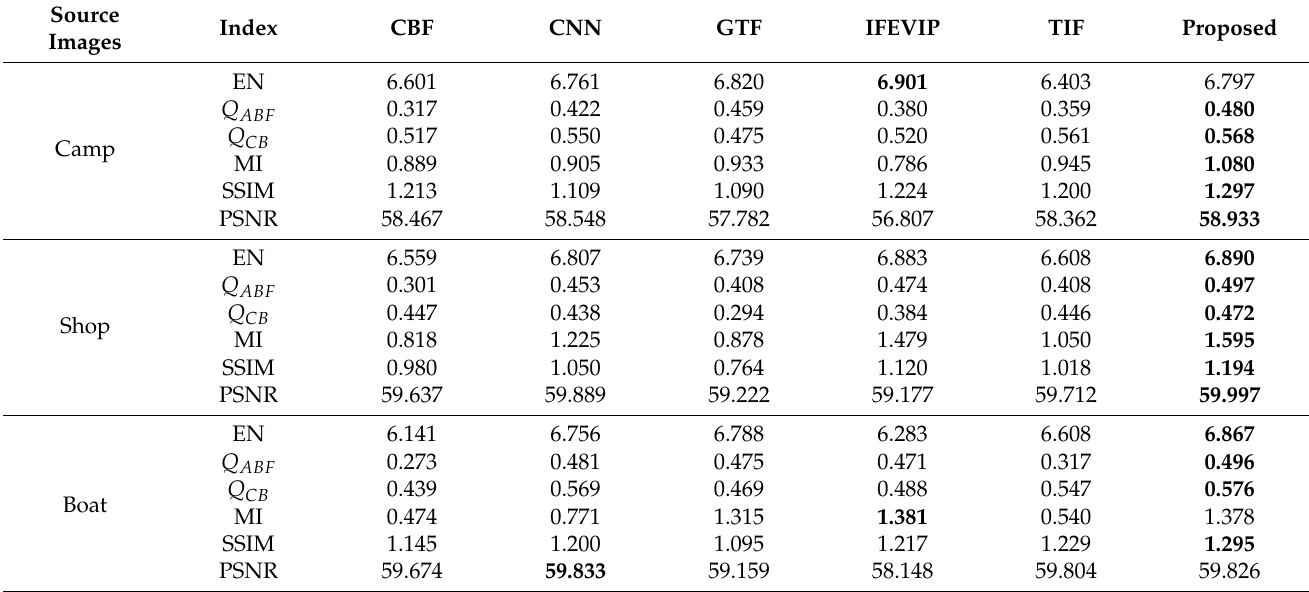
Table 1. Quantitative index of image fusion results ( σ =